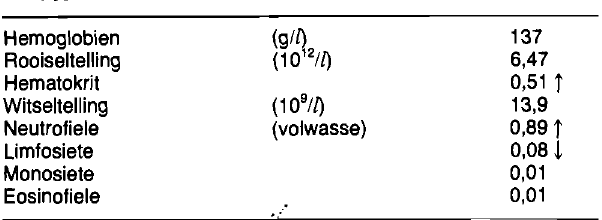
Tabel 2: KLiNIES-PATHOLOGIESE BEVINDINGS OP DAG 5 Hemoglobien Rooiseltelling , Hematokrit